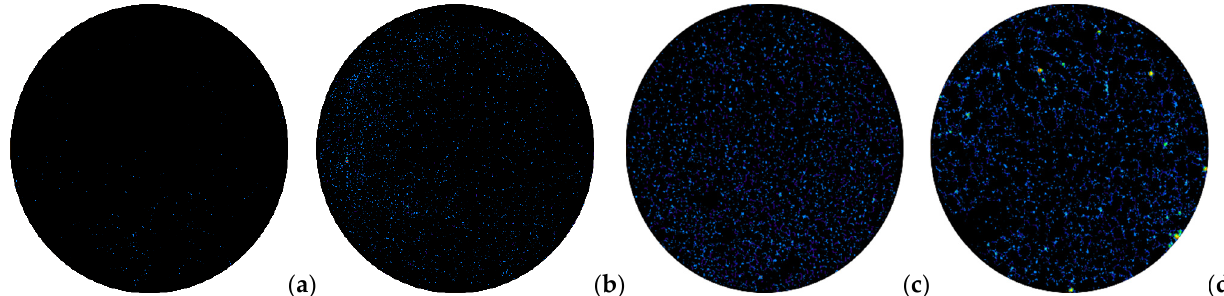
Figure 12. Cracks in soil sample after 1 WD cycle; ( a ) 0.25 mm; ( b ) 0.50 mm; ( c ) 2.00 mm; ( d ) 5.00 mm.